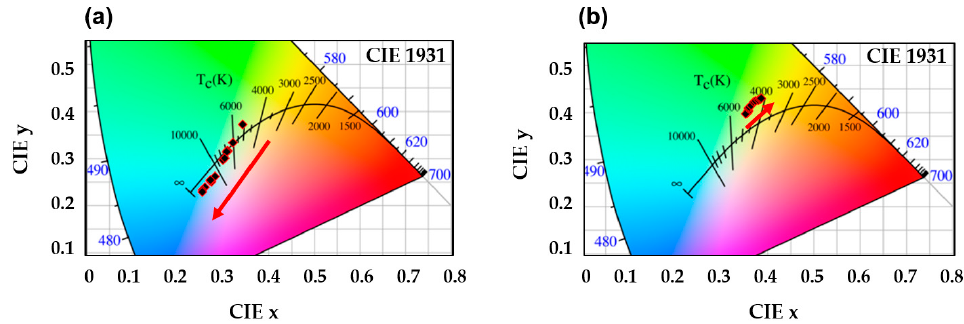
Figure 7. The chromaticity coordinate shift of WLED from 0 h to 1000 h. ( a ) RWQD-WLED and ( b ) LWQD-WLED.